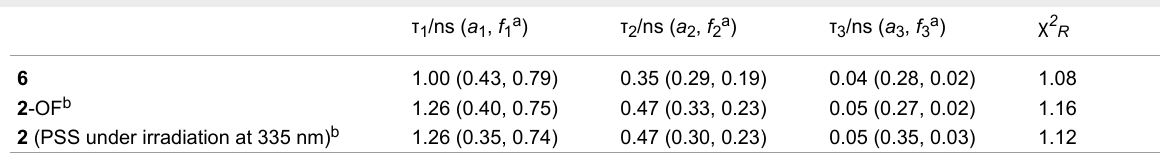
Table 1: Fluorescence decay parameters of compounds 6 and 2 in CH 3